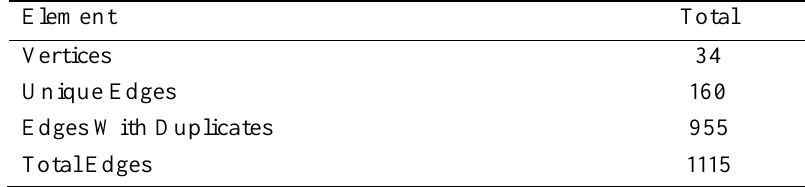
Overall Social Network Metrics for the Final Four Weeks Element Total Vertices 34 Unique Edges 160 Edges With Duplicates 955 Total Edges